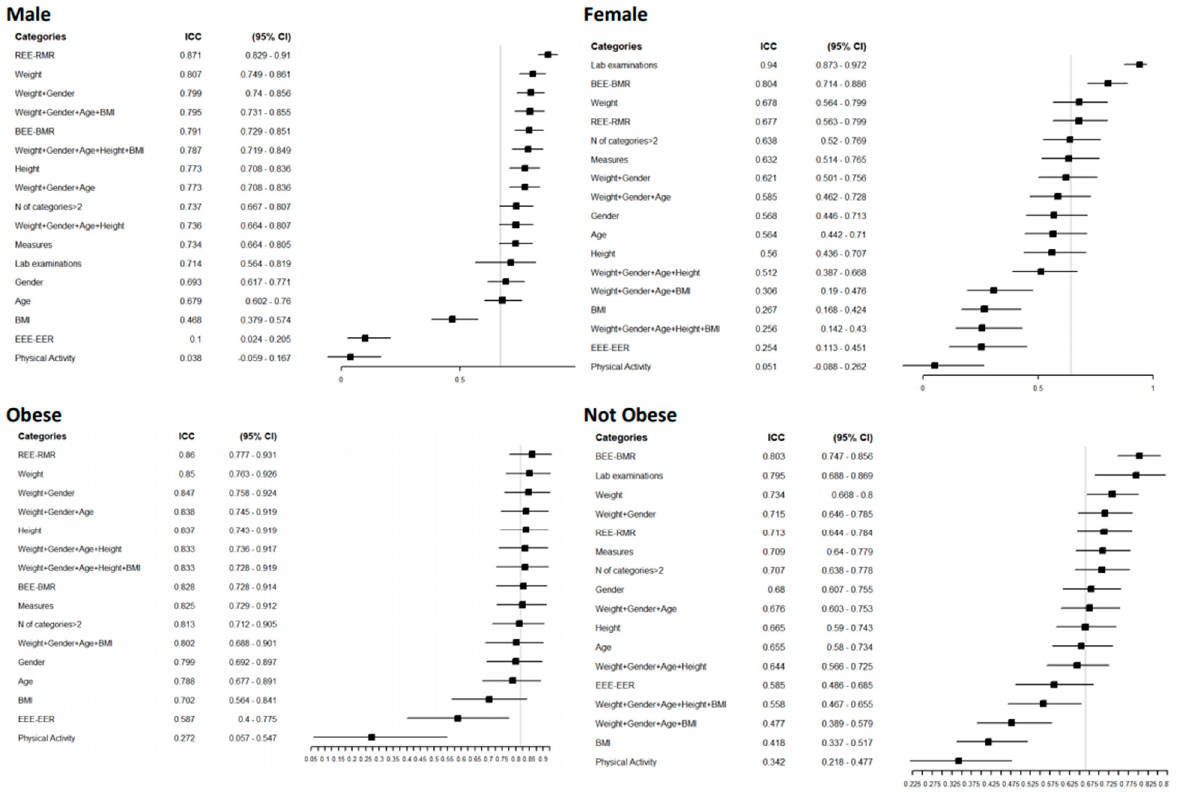
Figure 3. Forest plot reporting the Intraclass Correlation Coefficient (ICC) with 95% CI of estimated REE according to a specific category of patients for a specific group of predictive equations. The vertical grey line represents the ICC in each category without any grouping: Male ICC 0.64 [0.52–0.77] 95% CI, female 0.67 [0.59–0.75], obese 0.82 [0.72–0.90], normal weight 0.67 [0.59–0.74].